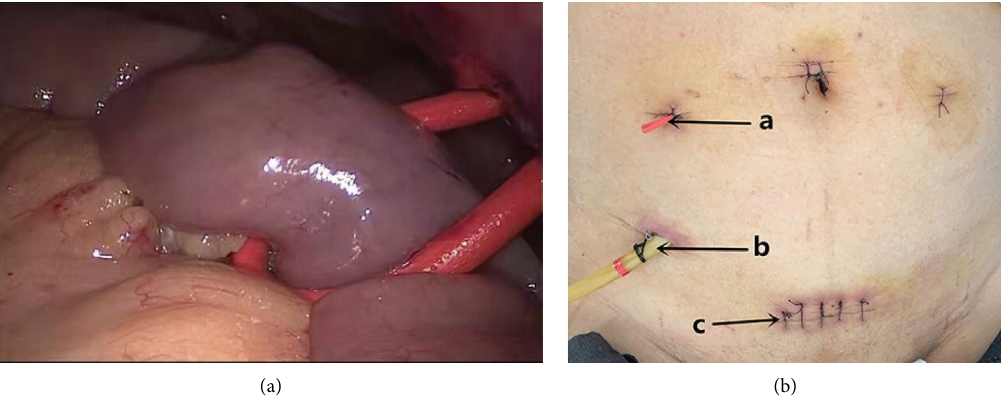
Figure 2: Ghost ileostomy. (a) Te distance from the suspended ileum to the ileocecal part is approximately 40cm. (b) Postoperative abdominal wall appearance. Notes. (A) fxation site at abdominal wall skin for ghost ileostomy suspension, (B) self-made double cannula, (C) median transverse incision of lower abdomen.